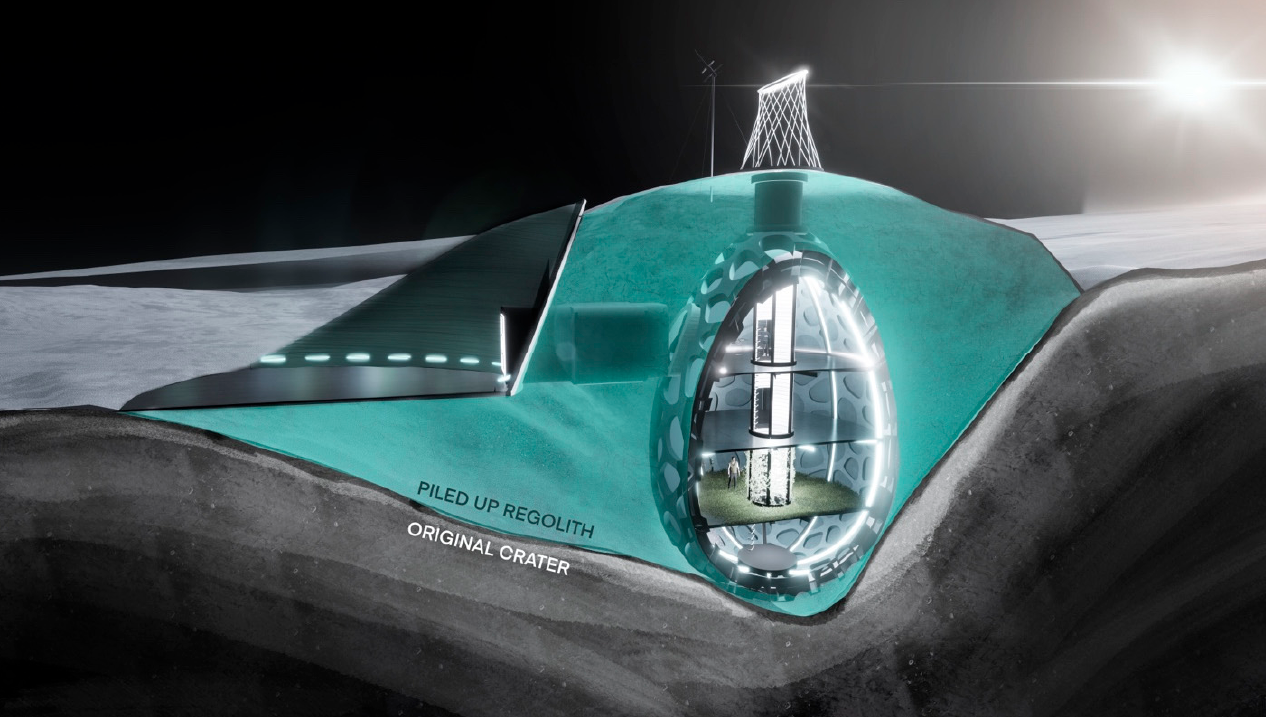
Figure 10. A view of a 3D section in the perspective of a semi-submerged habitat.